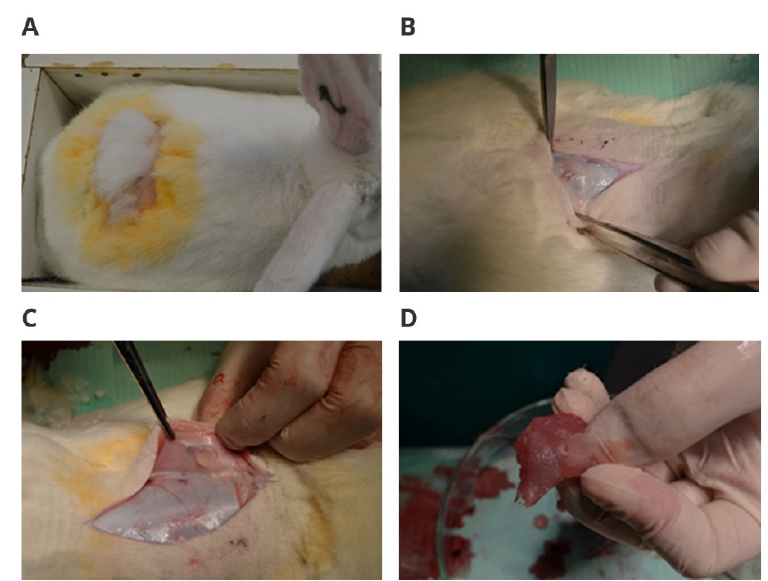
Figure 1. Macroscopically assessed postoperative scar and wound healing after implantation: ( A ) appearance of the postoperative wound 12 weeks after implantation; ( B ) appearance of subcutaneous tissue 12 weeks after implantation; ( C ) appearance of the dorsal subcutaneous tissue 12 weeks after implantation; ( D ) appearance of the longest muscle with an implant 12 weeks after implantation.